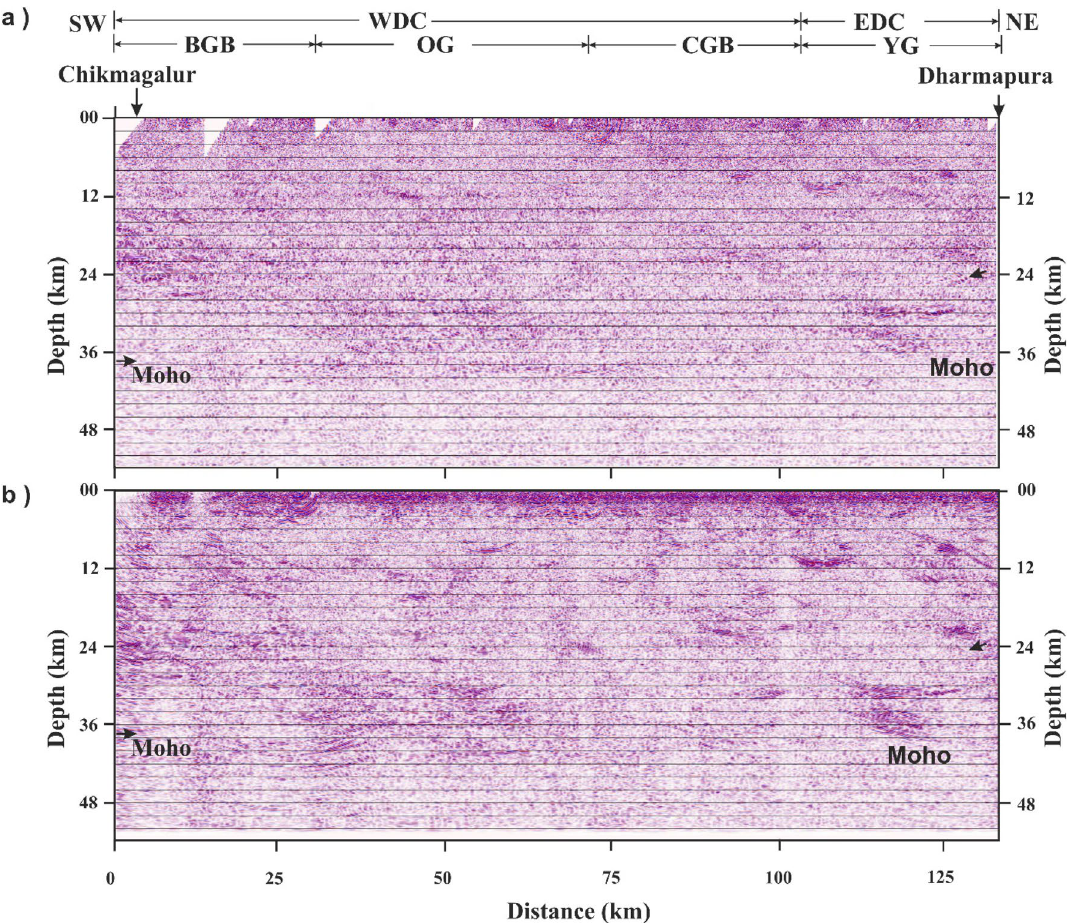
Figure 5. Comparison of conventional CMP and relatively new CRS time-migrated depth sections of the main profile. It shows differences in seismic sections due to differences in processing approach (see text for processing details). ( a ) No prominent reflection bands are observed in the seismic section, ( b ) The Moho is bright and continuous in CRS section (after Mandal et al. 21 ). Prominent NE dipping reflection bands are observed at the beginning and end of the seismic